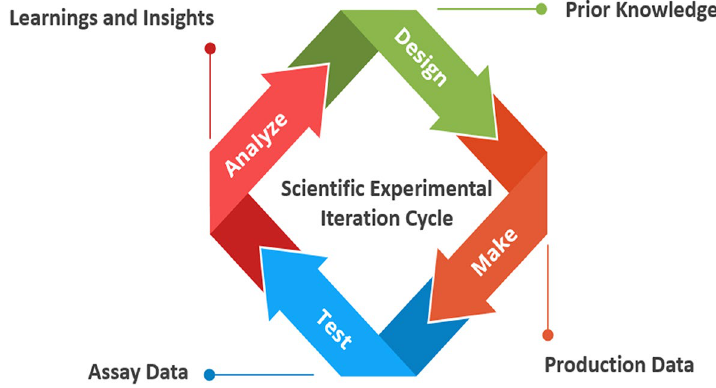
Fig. 1 Iterative scientific experimental cycle and accompanying information